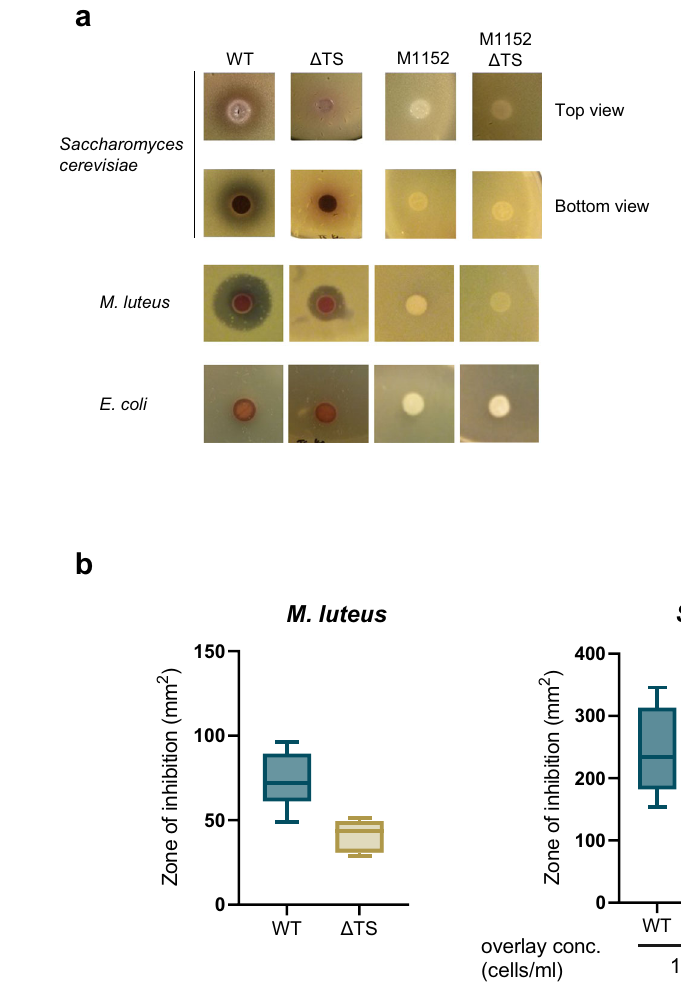
Fig. 2 | Interspecies growth inhibition induced by WT and eCIS-de fi cient Sco strains. Assayswereperformed byspottingonagarplates10 5 SFUof Sco wild-type (WT), tail sheath knockout ( Δ TS), M1152 (a mutant that does not produce the four major Sco antibiotics), or M1152 harboring a tail sheath knockout mutation (M1152 Δ TS).Cellsweregrownfor3daysbeforebeingoverlaidwithspeciestobetestedas indicated in each panel. a Zones of clearing around the Sco colonies indicate lethality or growth inhibitory activity against the indicator lawn. All of the results shownfor a tested strain were obtained fromthe same agarplate. b The inhibitory